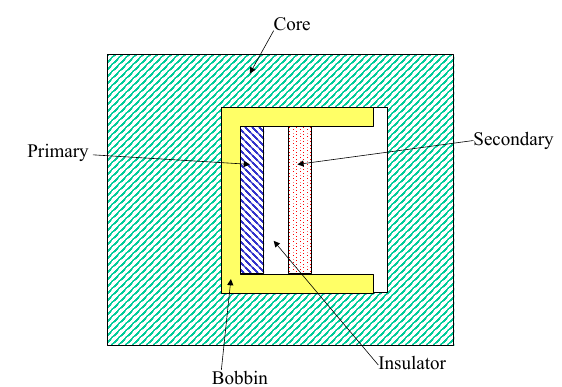
Figure 2: Theoretical and empirical leakage inductance variation with frequency